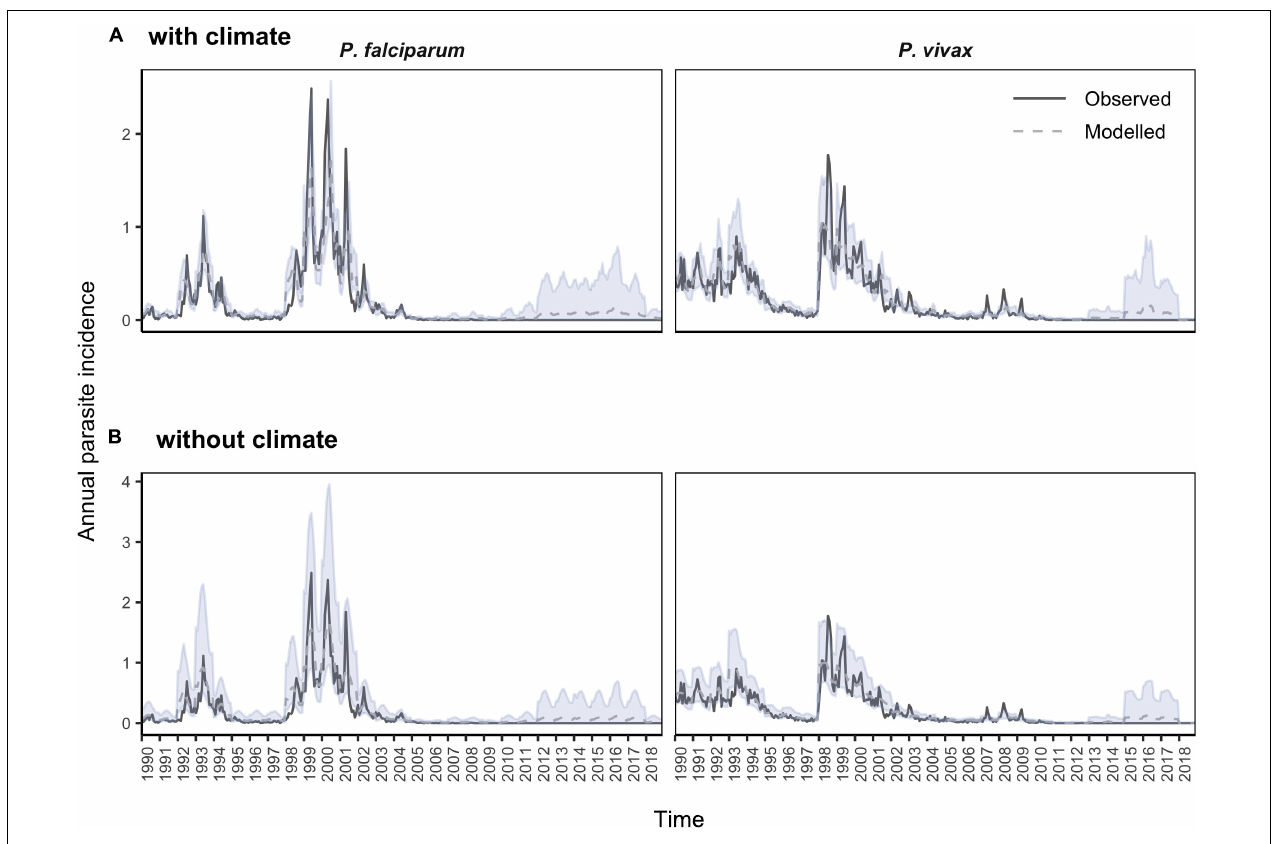
FIGURE 5 | Model posterior distributions with and without climate information for P. falciparum and P. vivax malaria in El Oro 1990–2018. Observed (gray solid line), posterior mean (blue dashed line) and 95% credible intervals (blue shading) for annual parasite incidence (API) for (A) models that include minimum temperature, lagged by 3 months and precipitation, lagged by 3 months for P. falciparum models and 1 month for P. vivax models and (B) without climate information. For models of P. falciparum malaria minimum temperature and precipitation were included as linear terms. For P. vivax malaria models, model fit improved when including non-linear functions of minimum temperature and